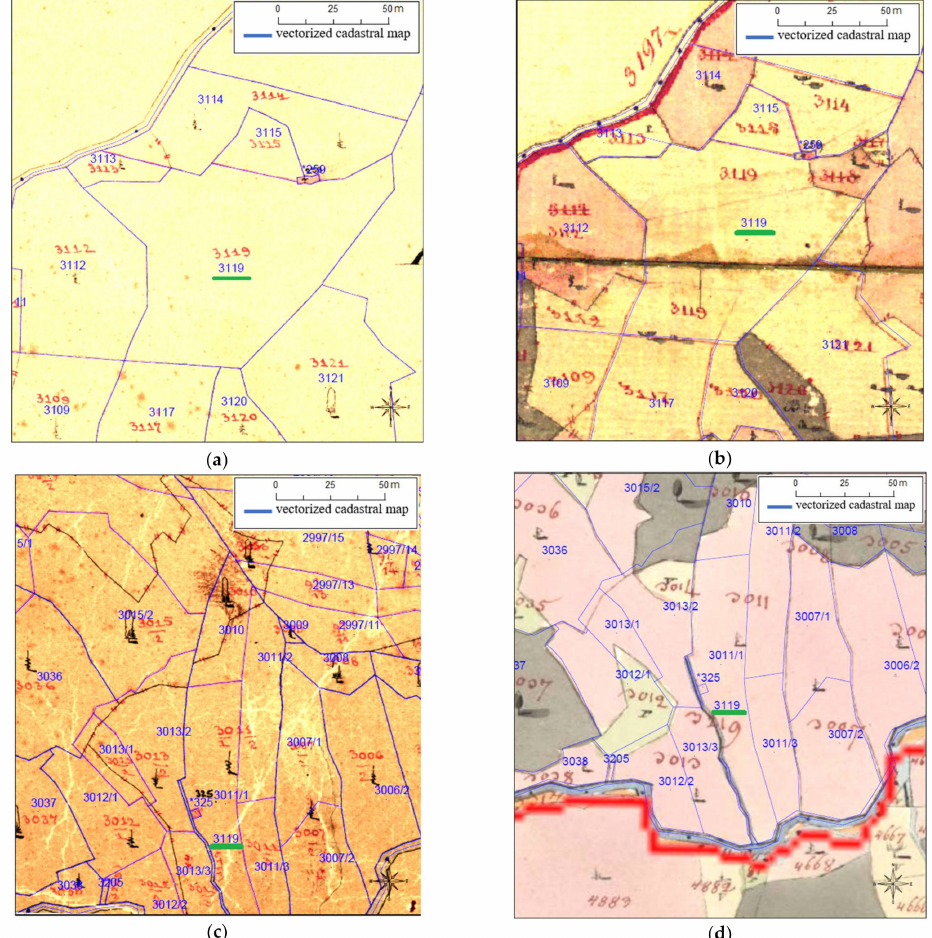
Figure 7. Lithography-caused inconsistency: ( a ) vectorized and cadastral map position 1; ( b ) vectorized and historicalcadas- tral map position 1; ( c ) vectorized and cadastral map position 2; ( d ) vectorized and historical cadastral map position 2. Source: own